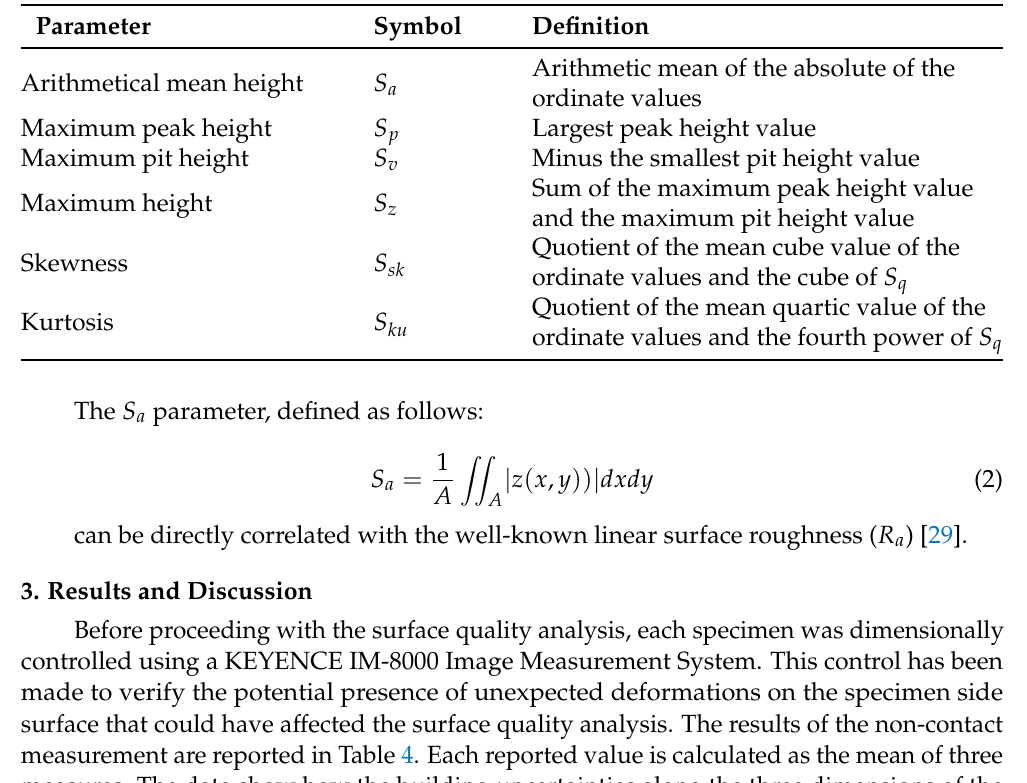
Table 3. Parameters for the determination of surface texture by areal methods